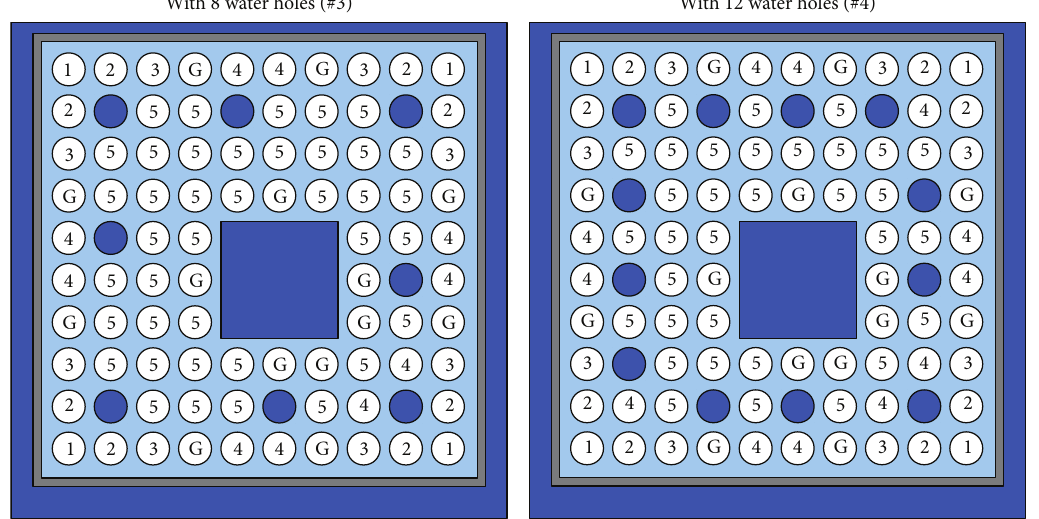
Figure 1: Innovative and modified designs of